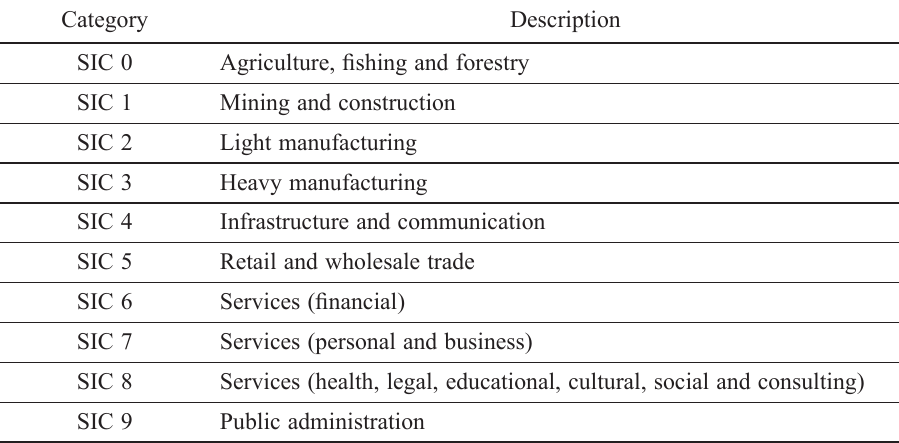
Table 1. Broad classification of the different categories of goods